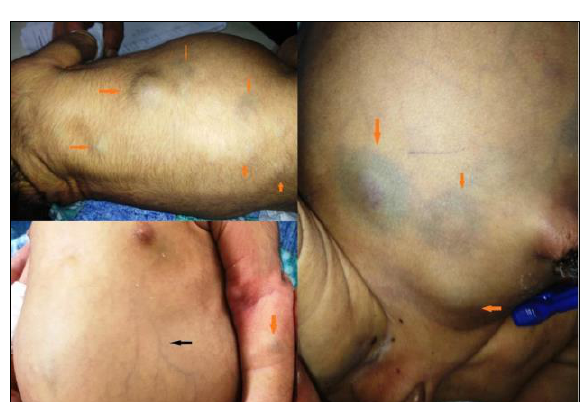
Figure 1: Photographs showing multiple blueberry muffin nodules and papules over the back (orange arrows), forearm (orange arrow), and lower abdomen (orange arrows); dilated veins visible over the abdomen (black arrow).